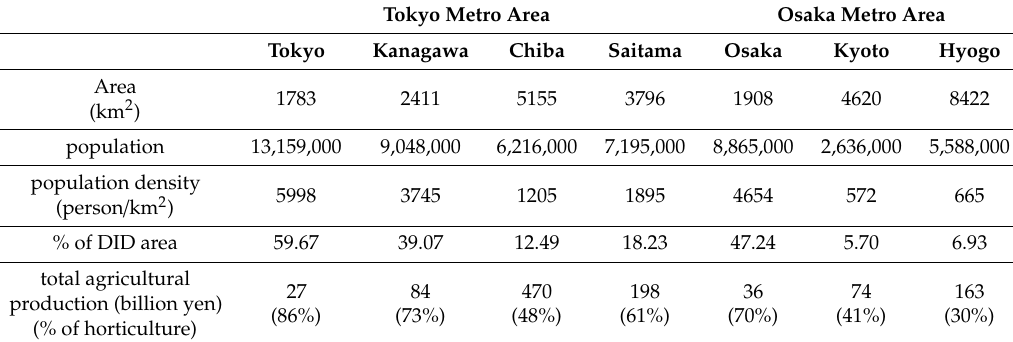
Table 1. Characteristics of each prefecture.